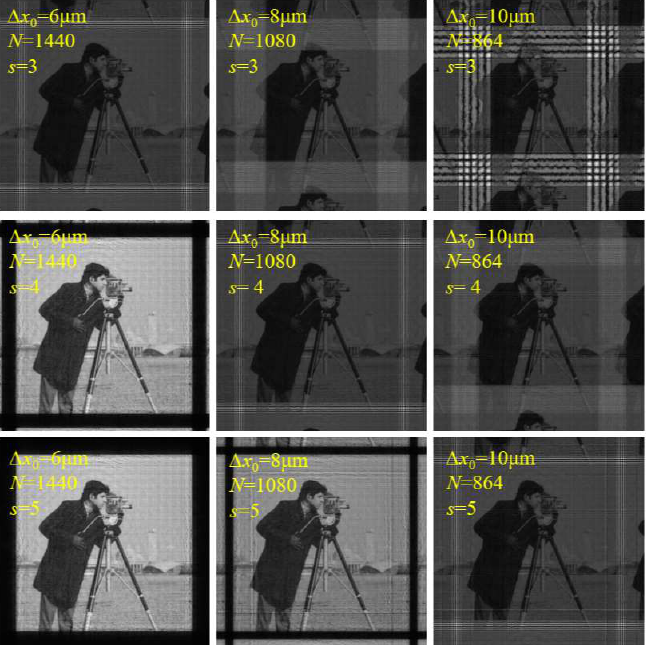
Figure 12. Calculated amplitude distributions on diffraction plane with different ∆ x 0 and different s using MPASM.